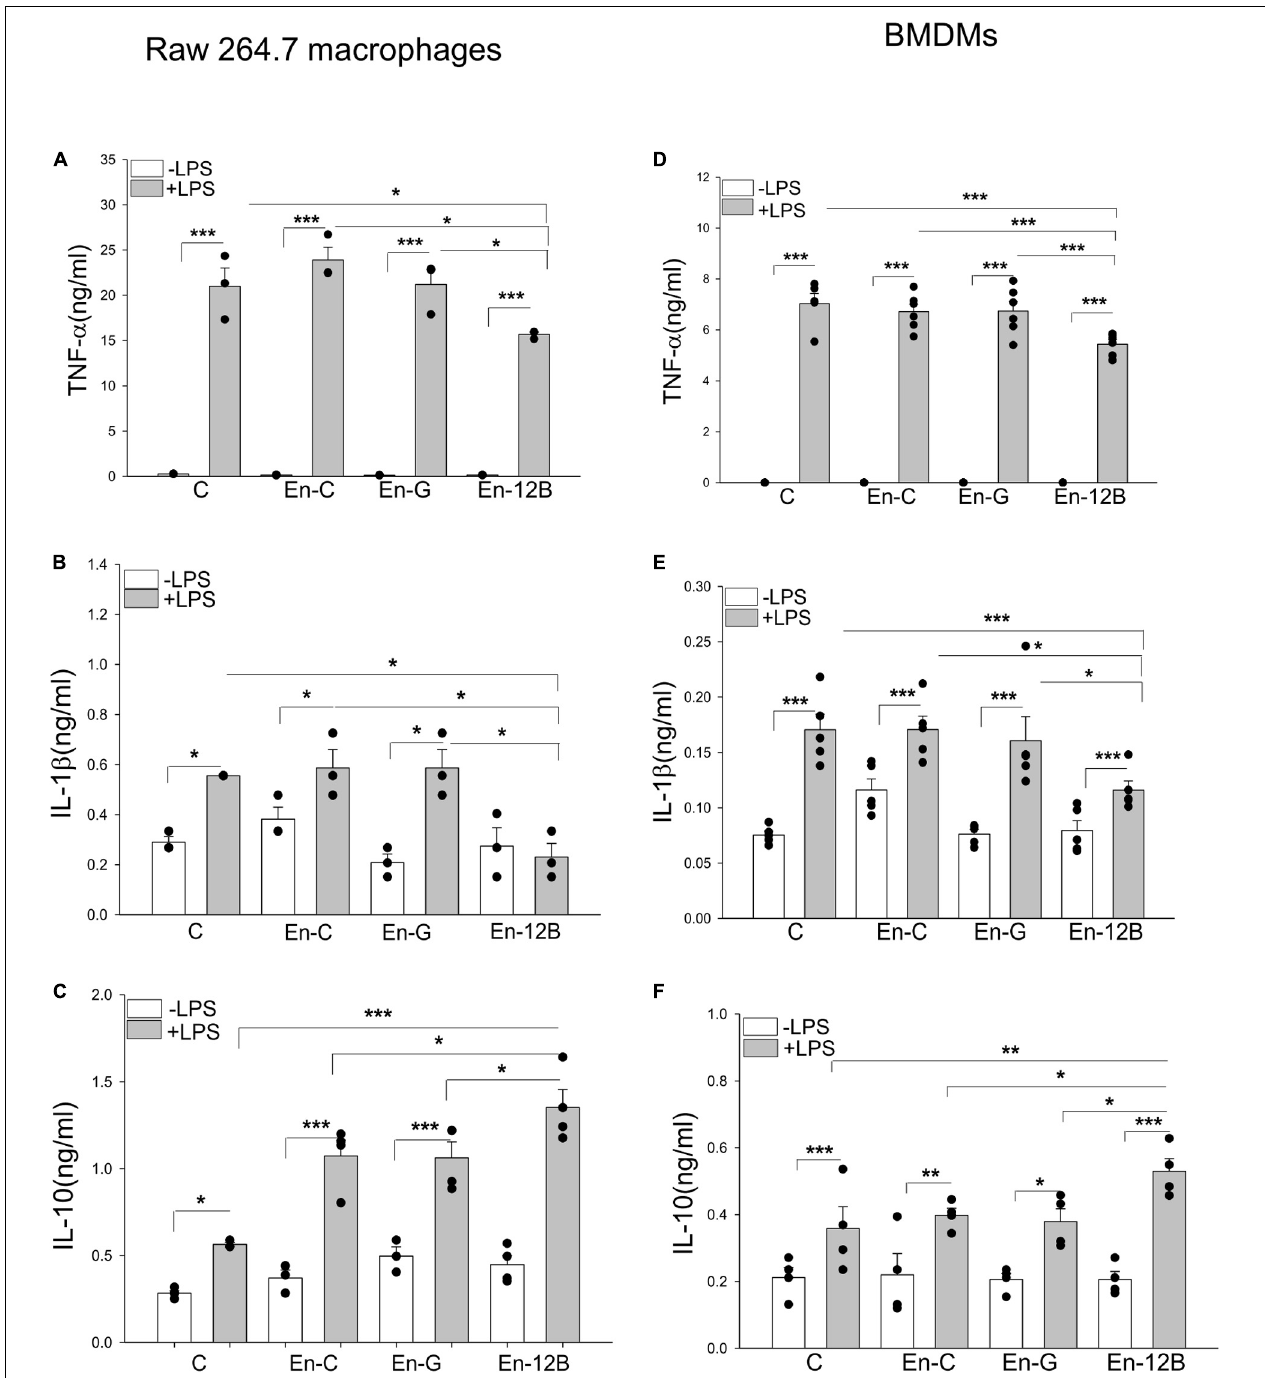
FIGURE 5 | Endothelial conditioned medium (ECM) altered macrophage response to LPS stimulation. Macrophages (Raw 264.7) were incubated with ECM followed by LPS (1 µ g/ml) stimulation for 24 h. The medium were collected for the measurement of TNF α (A) , IL-1 β (B), and IL-10 (C) by ELISA. (D–F) Bone marrow derived macrophages (BMDM) were incubated with ECM followed by LPS (1 µ g/ml) stimulation for 24 h. The medium were collected for the measurement of TNF- α (D) , IL-1 β (E) and increased IL-10 (F) by ELISA. C, control; En-C, endothelial medium control; En-G, Ad-GFP endothelial medium; En-12B, Ad-HSPA12B endothelial medium control. n = 3 ∼ 6/group. * P < 0.05, ** P < 0.01, and *** P < 0.001 compared with indicated